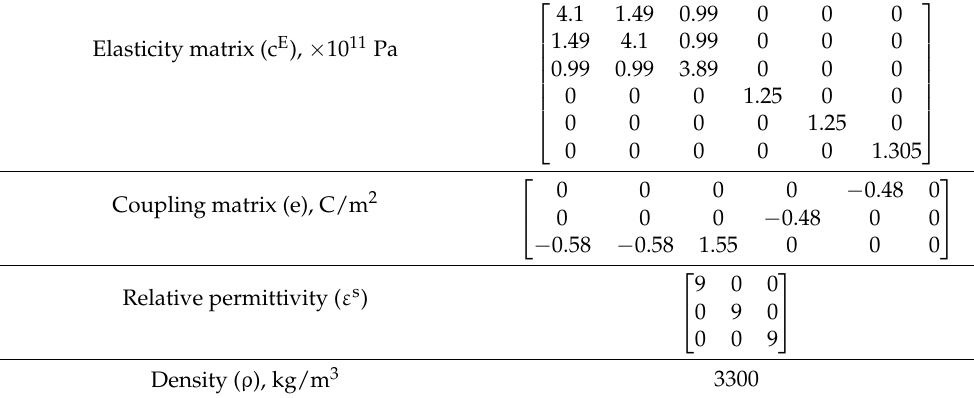
Table 1. AlN piezoelectric material properties used for FEM